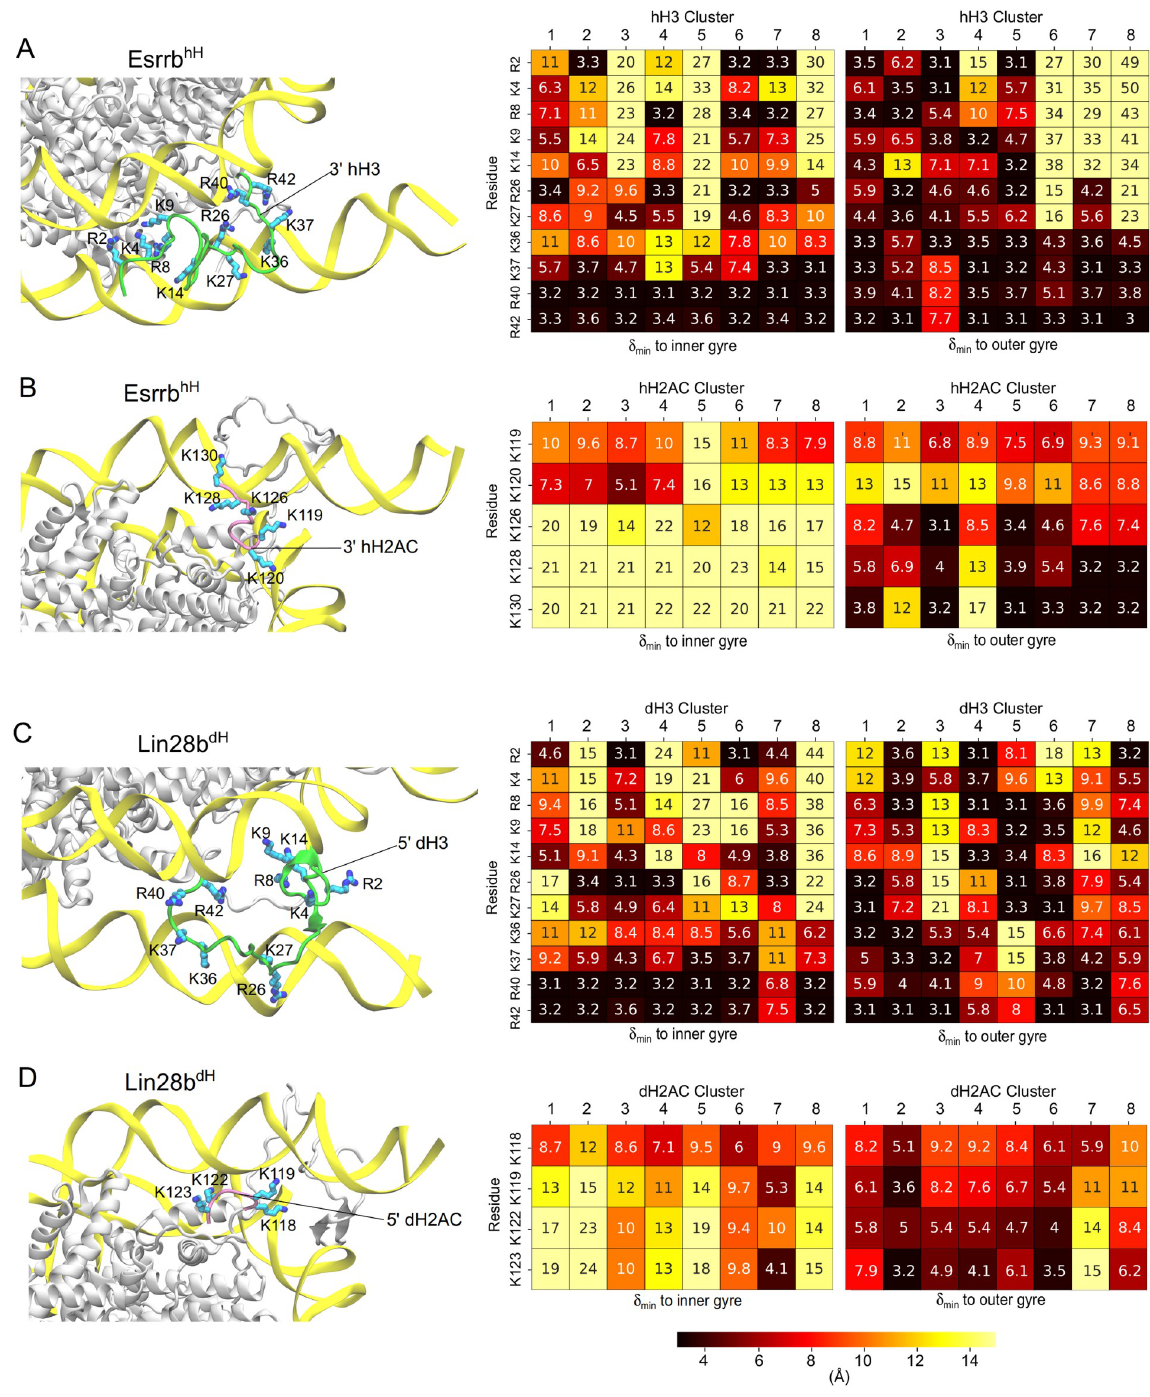
Fig 8. Interactions of epigenetic regulatory residues from the histone tails with DNA. Each panel shows a structural illustration of the histone tail (left) and 2 heatmaps with minimal distances of the analyzed residues to the inner (middle) and outer gyre of the DNA (right). (A-B) the hH simulations. (C-D) the dH simulations. The H3 (A,C) and H2AC (B,D) tails are shown as green and mauve ribbons with the analyzed aminoacids colored by atom name. The DNA is in yellow ribbons and the core histones are in white. The heatmaps show the analyzed residues on the vertical and the DNA clusters on the horizontal. The numbers are the median value of the minimal distance of each residue to the DNA in the corresponding DNA cluster.